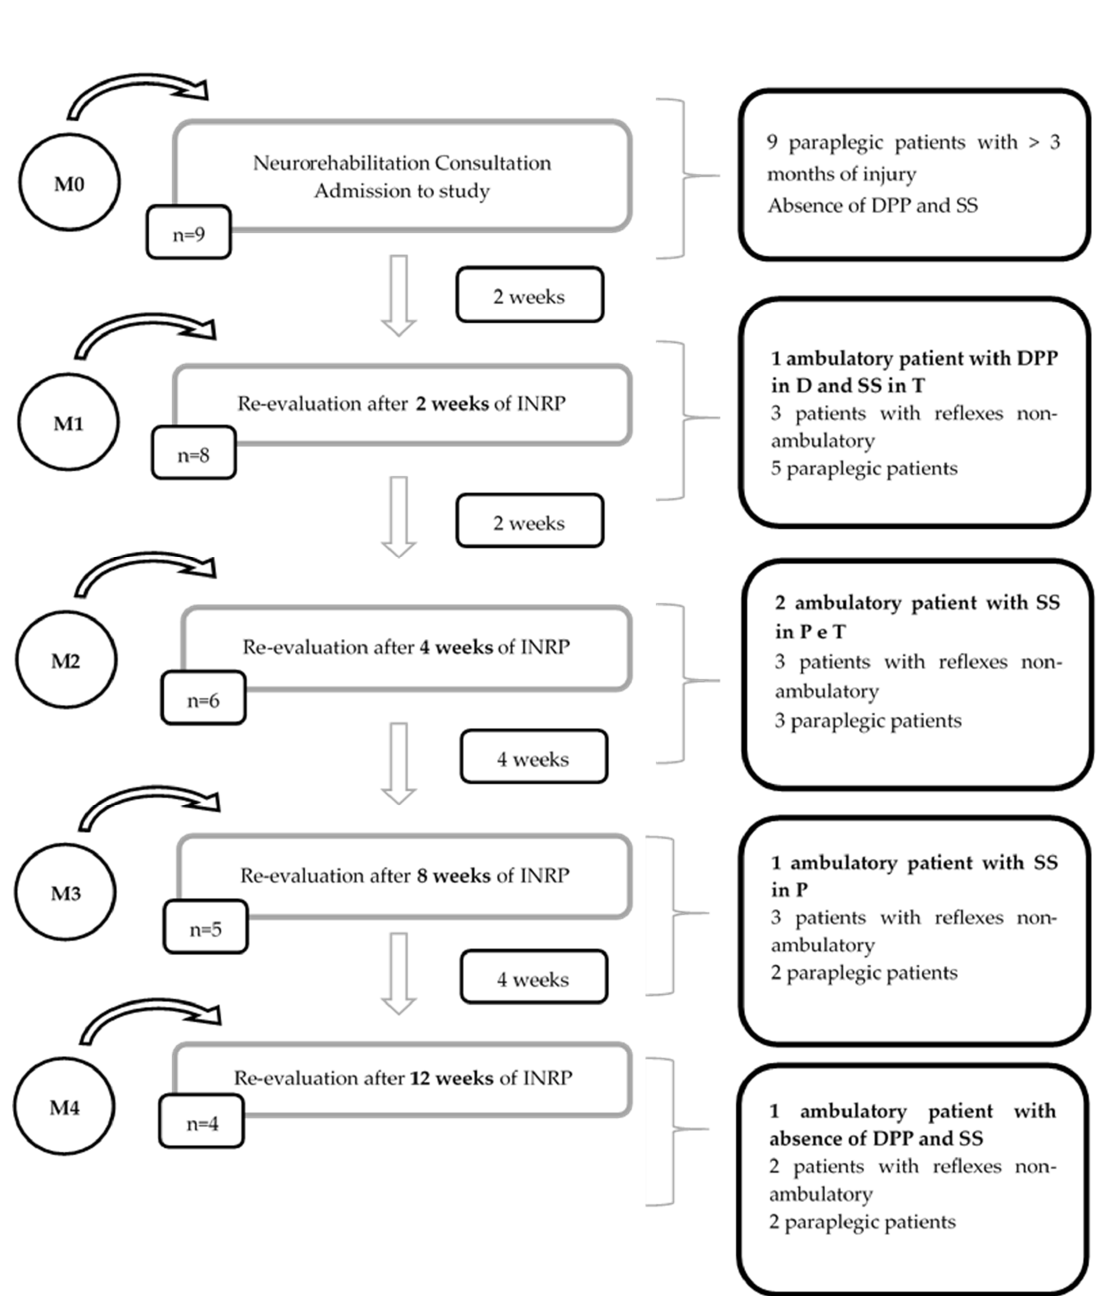
Figure 5. Patient progression algorithm in the study. DPP: deep pain perception; SS: superficial sensitivity; P: perineum; T: tail; D: digits.